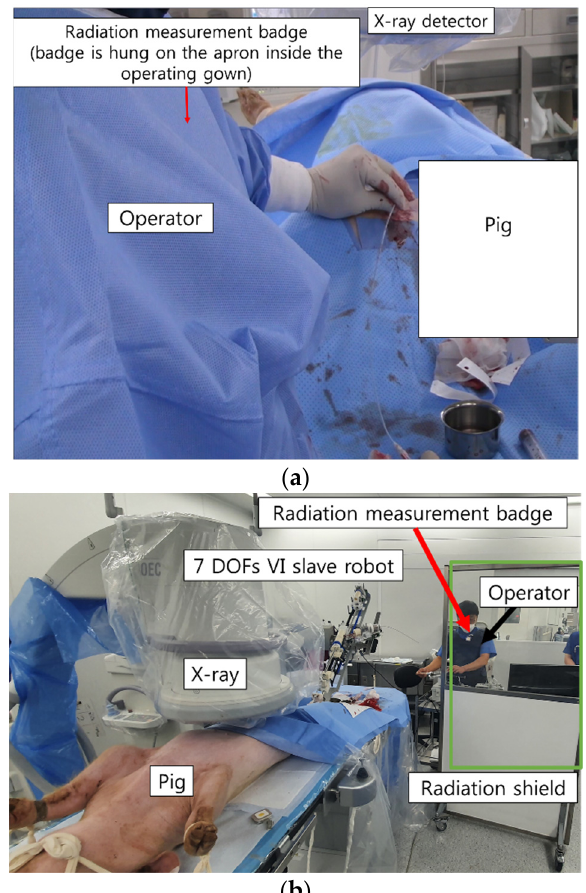
Figure 9. Experimental conditions for measurement of radiation exposure: ( a ) conventional VI procedure; ( b ) robotic VI procedure.